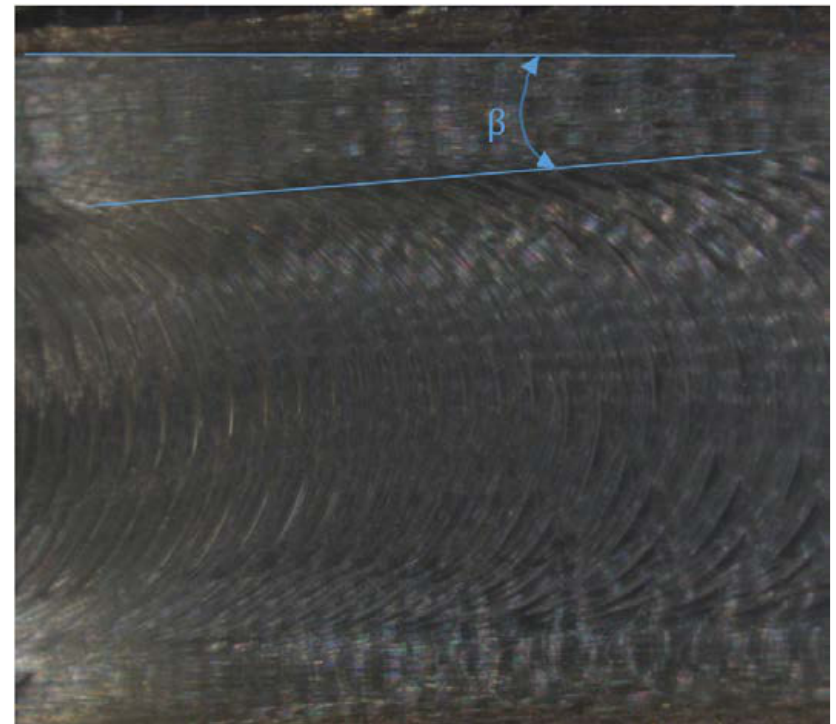
Figure 3. Traces created during turn-milling—magnification × 10.